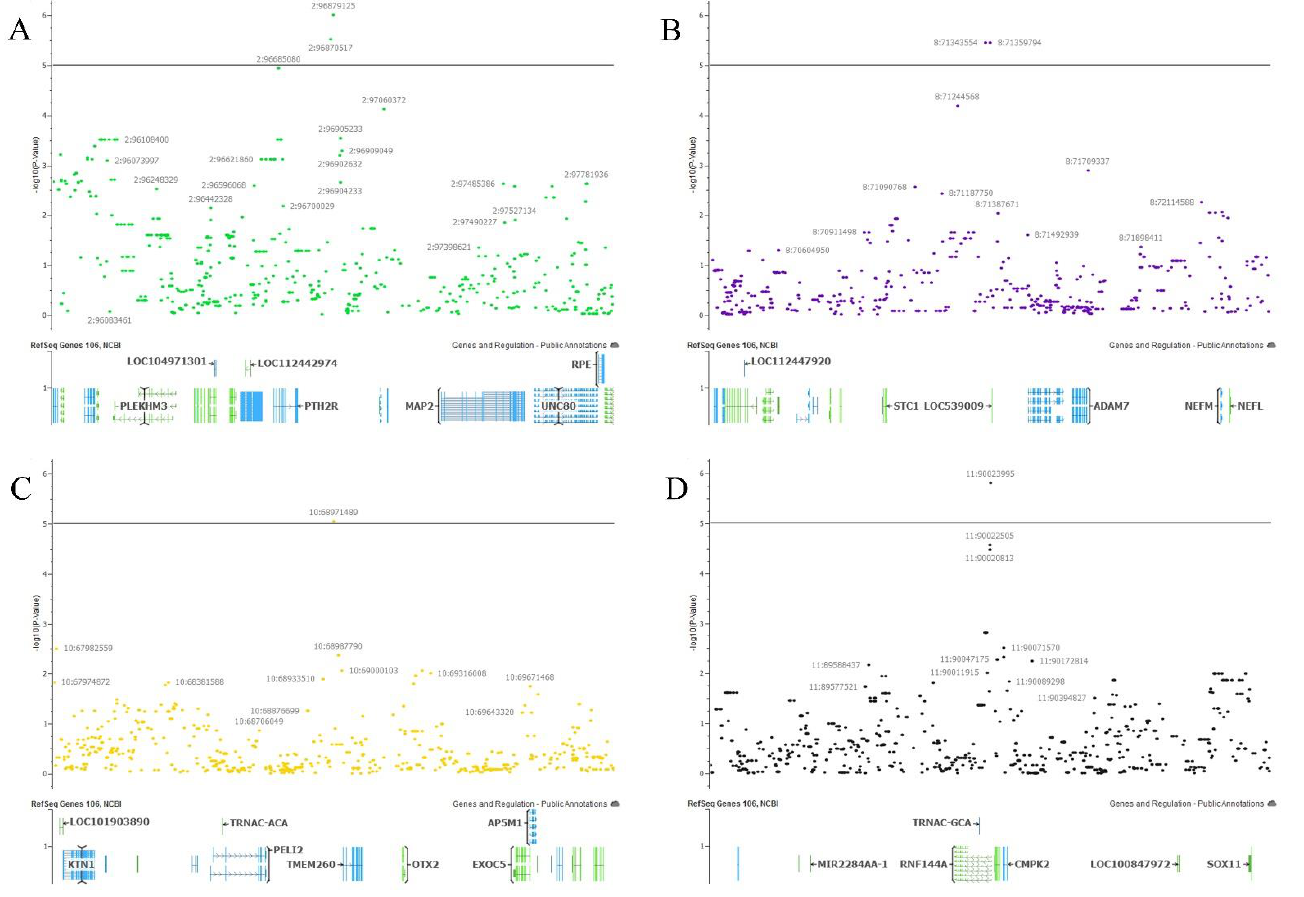
Figure 5. Regions within 1 Mbp of the most significant SNP for the reproductive tract scores (RTS) GWAS results for ( A ) chromosome 2; ( B ) chromosome 8; ( C ) chromosome 10; ( D ) chromosome 11.